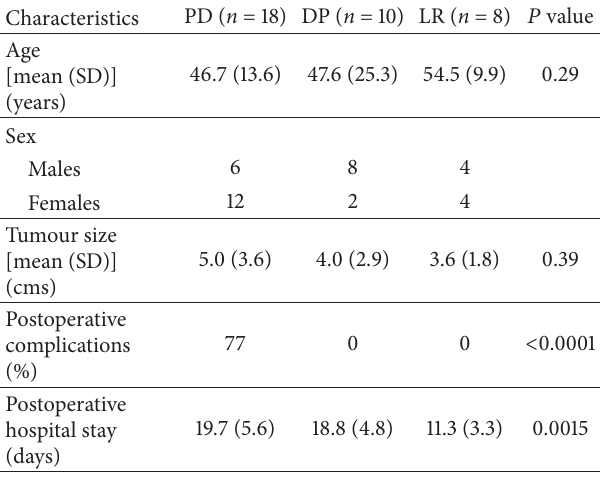
Table 6: Comparisons of the resective procedures with respect to demographics, tumour size, postoperative complications, and post- operative hospital